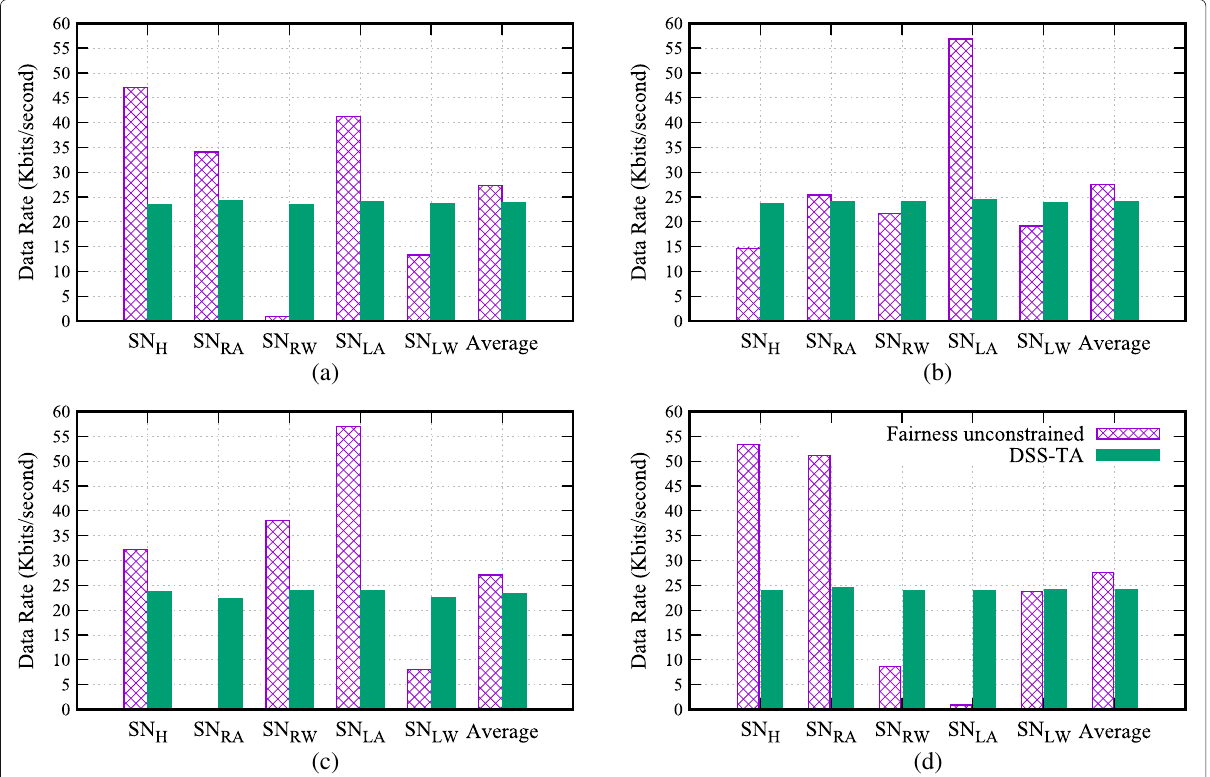
Fig. 11 The comparison of upload data rate between DSS-TA and the fairness unconstrained method, superframe length 70 ms, P Tx = –15 dBm. a Channel dataset 1 (CD 1 ). b Channel dataset 5 (CD 5 ). c Channel dataset 9 (CD 9 ). d Channel dataset 13 (CD 1